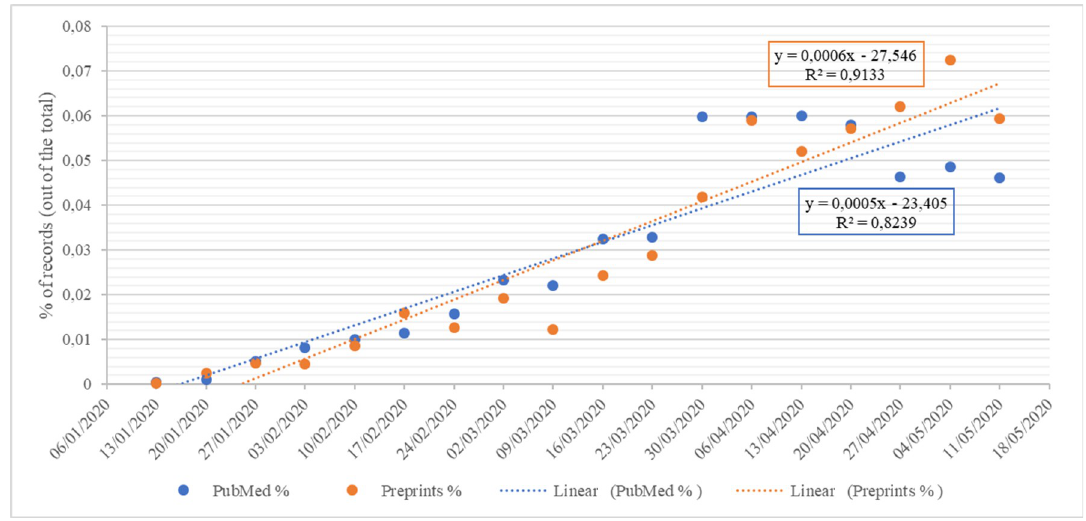
Fig 1. Linear regression over time for academic and preprint publications. Dates: 10 January 2020—first genomic data of its etiological agent (SARS-CoV-2); 20 January 2020—reports of confirmed cases from three countries outside China; 24 January